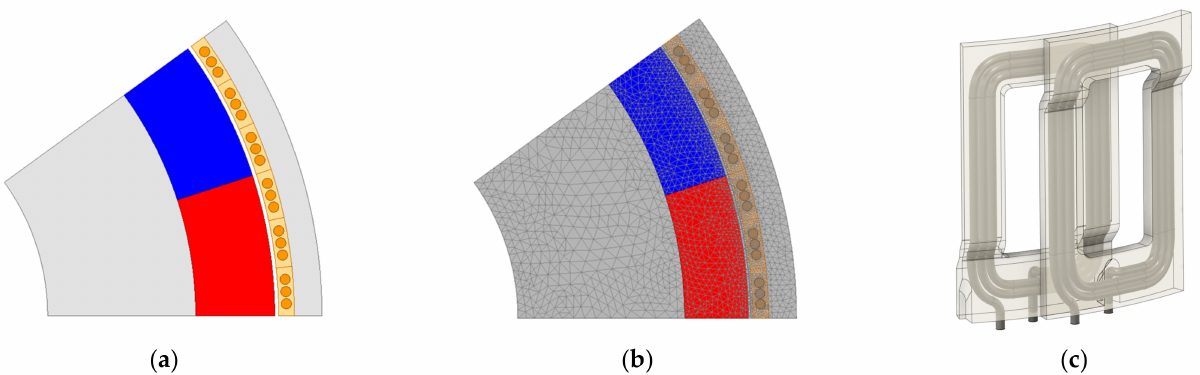
Figure 10. Final model shape: ( a ) FEA model; ( b ) mesh plot of FEA model; ( c ) units of